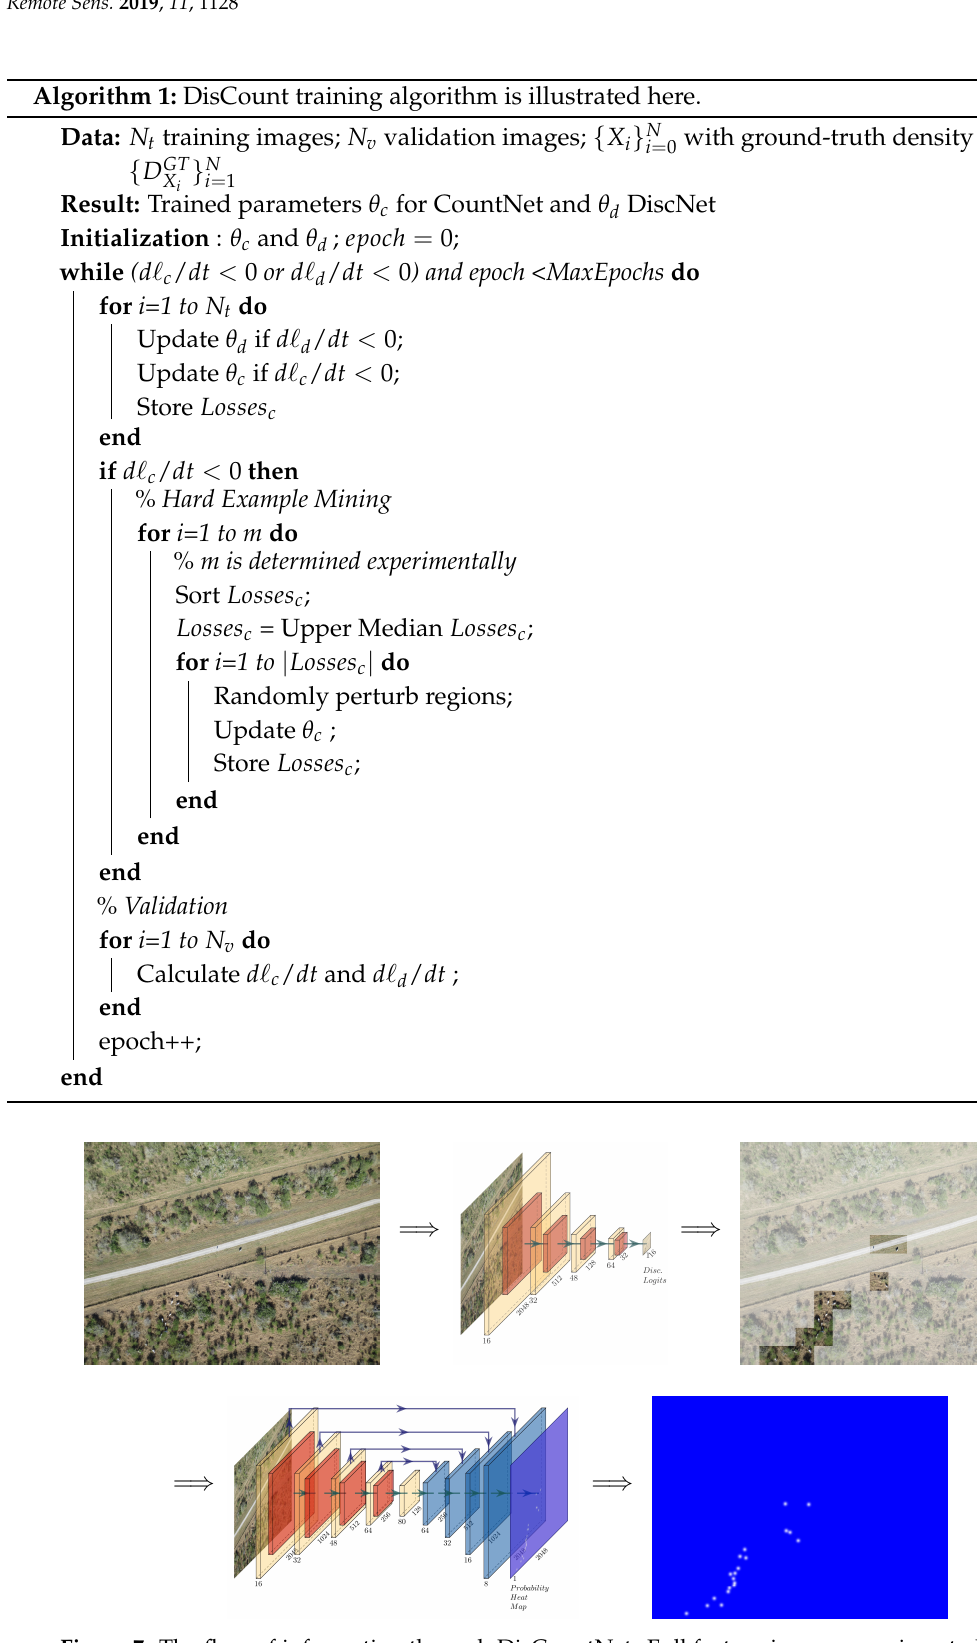
Figure 7. The flow of information through DisCountNet. Full feature images are given to DiscNet, which generates a sparse representation of the image to give to CountNet. CountNet then operates on this sparse representation to generate a per-pixel probability that a cow is in a given pixel. These values, when summed up, equal the predicted number of cows in the